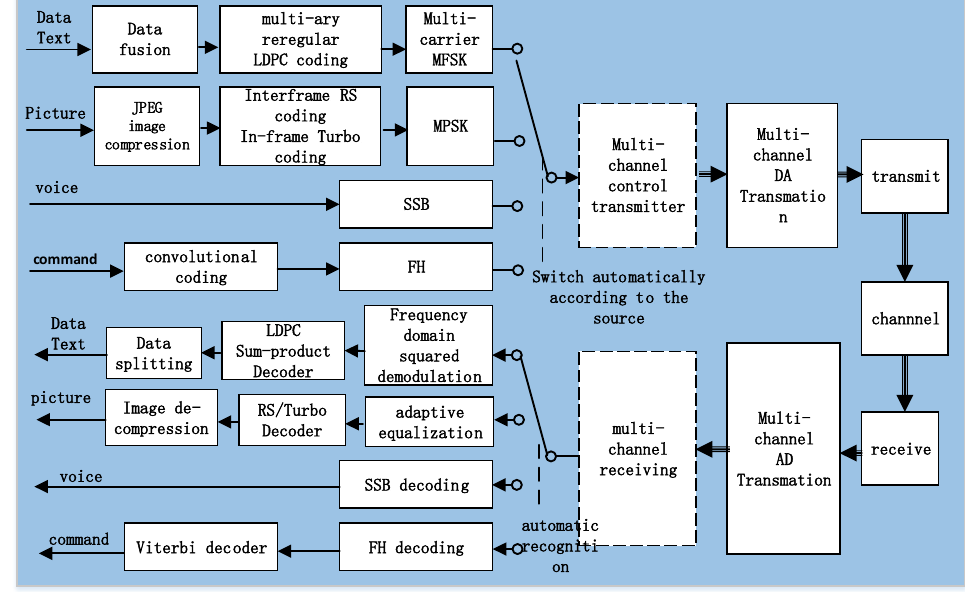
Figure 3. Schematic diagram of the underwater acoustic communication system.